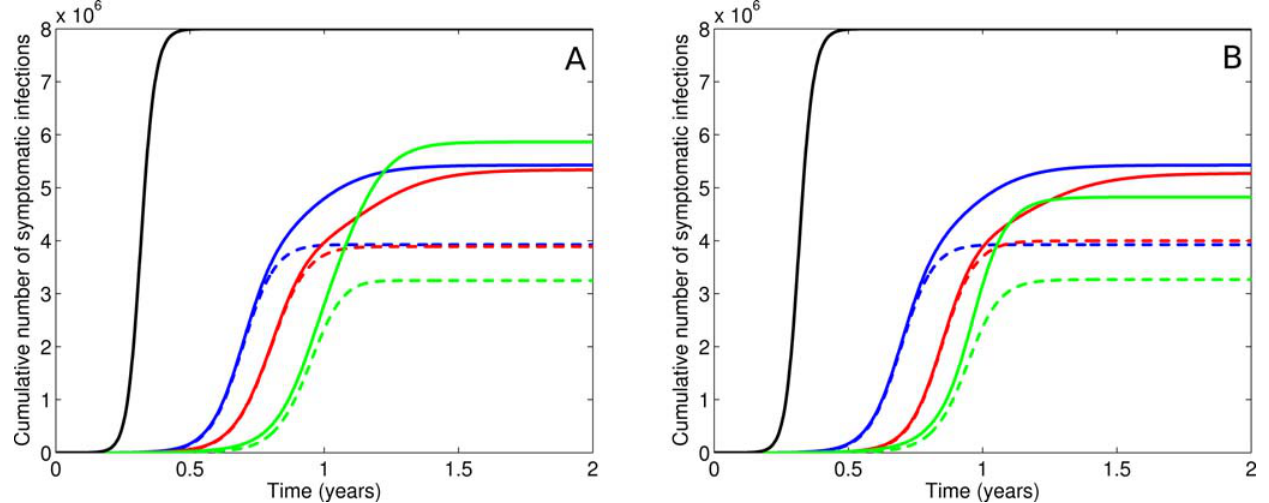
Figure 6. Strategic use of one or two drugs: cumulative infections. a. Cumulative infections for a 90/10 stockpile. Colours as in Figure 5a. The solid line is total infections. The dotted line is resistant infections (single-drug and multi-drug resistant). All interventions result in a reduced attack rate. The T&P strategy has a measurably reduced proportion of resistant infections and thus, at stockpile expiry, the wild-type strain dominates, resulting in the highest overall attack rate (but the longest delay). b. As for Figure 6a but with a 50/50 stockpile.